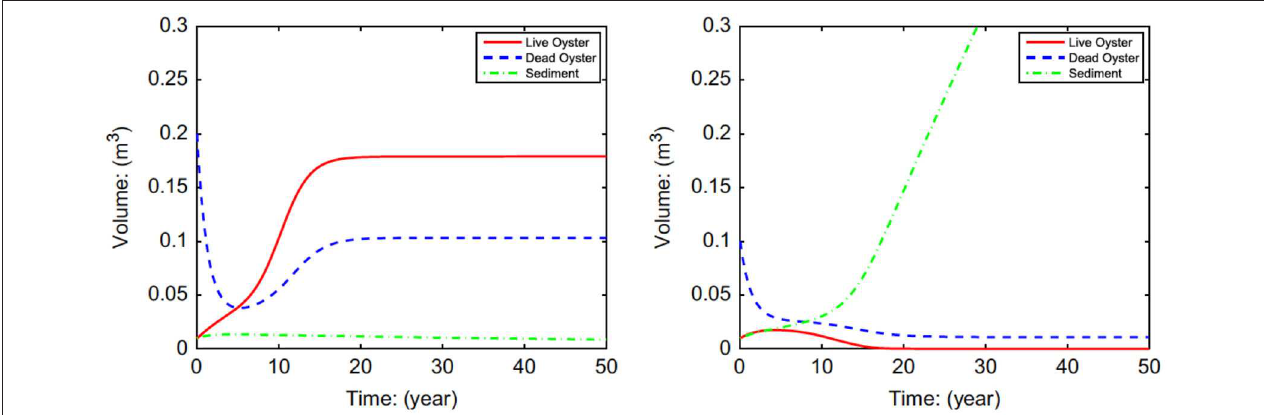
FIGURE 3 | Simulations of volume of live eastern oysters N ( Crassostrea virginica ), dead oyster reef R , and sediment S as a function of initial reef height R t = 0 , demonstrating alternative stable states of a positive equilibrium ( left ) and extinction ( right ). For all cases N t = 0 = 0.01 and S t = 0 = 0.01. ( upper left ) R t = 0 = 0.20; ( upper right ) R t = 0 = 0.10. Figure reproduced with permission (Elsevier license 4451990372334) from Jordan-Cooley et al. (2011).